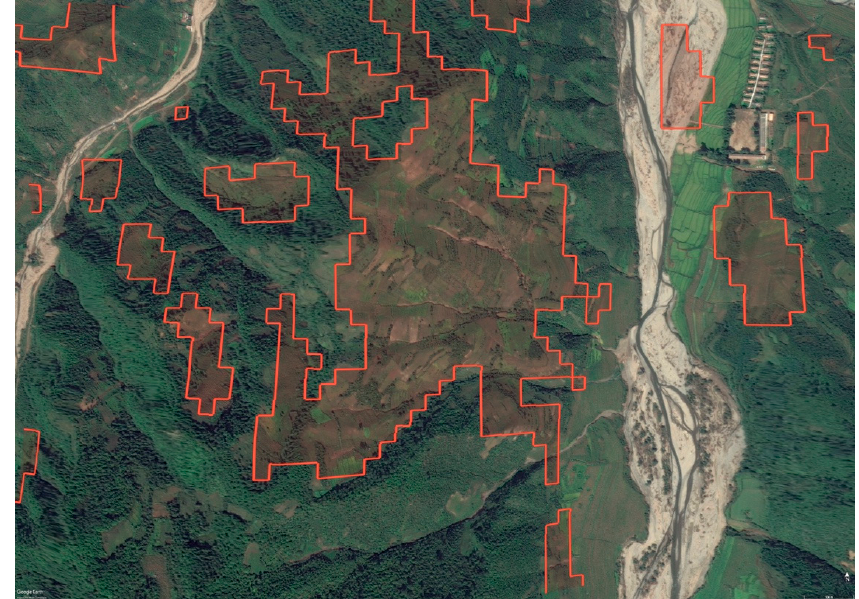
Figure 3. Visual interpretation of deforestation with high-resolution Google Earth imagery.